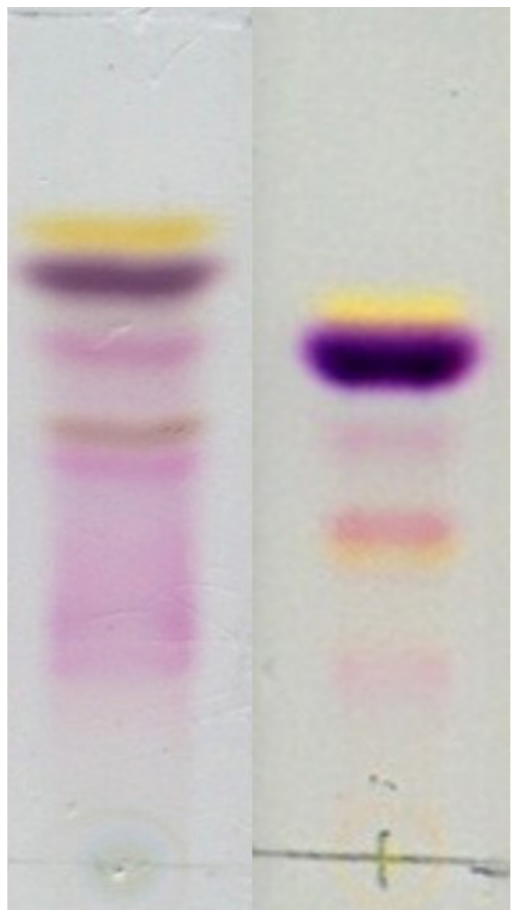
, gray line) of R fDPPH• and R fDPPH-H on the Hildebrand parameter, d . ▲